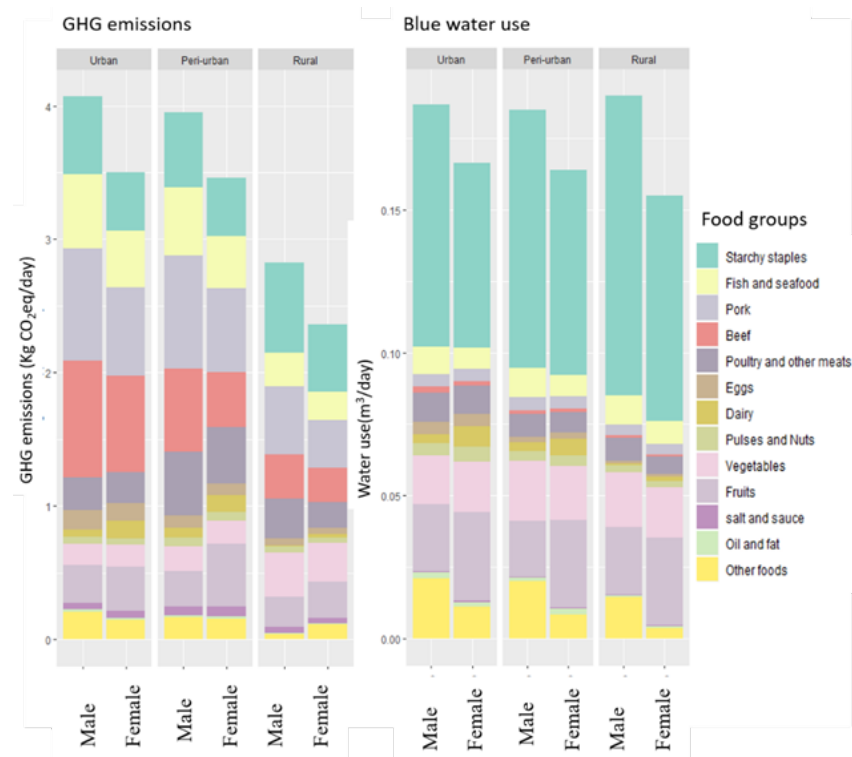
Figure 5. Average environmental footprints for male and female household members by district. Figure 6 shows environmental footprints per 2000 Kcal by gender and district (their detailed values are in Tables A6 and A7). Interestingly, the average GHGE normalized per 2000 Kcal was lower than the dietary GHGE per day for both genders in three districts, except for males in the rural district, meaning that most diets averaged below 2000 Kcal/day. Similar to the per-day results, the average GHGE per 2000 Kcal from the rural district was much lower than that of urban and peri-urban districts. There was a similar trend for blue water use since the average blue water use normalized per 2000 Kcal was slightly higher than the dietary blue water use per